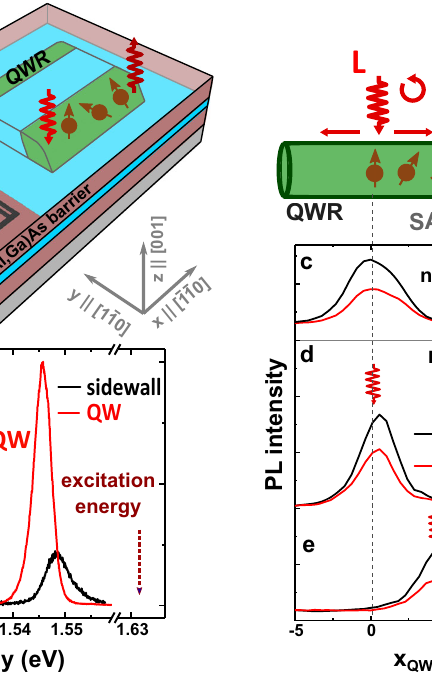
sidewall showing the emission lines of the QW (1.548eV) and QWR (1.521eV), respectively. c – e Pro fi les of the right (black, I ↺ PL ) and left (red, I ↻ PL ) circularly polarized PL along the QWR axis ( x QWR coordinate) recorded under the con fi g- urationillustratedintheupperpanel( c )intheabsenceand( d , e )underaSAW.The PL was excited by a right-circularly polarized laser spot focused at x QWR =0 for ( c ) and ( d ), and at x QWR =4.5 μ m for ( e